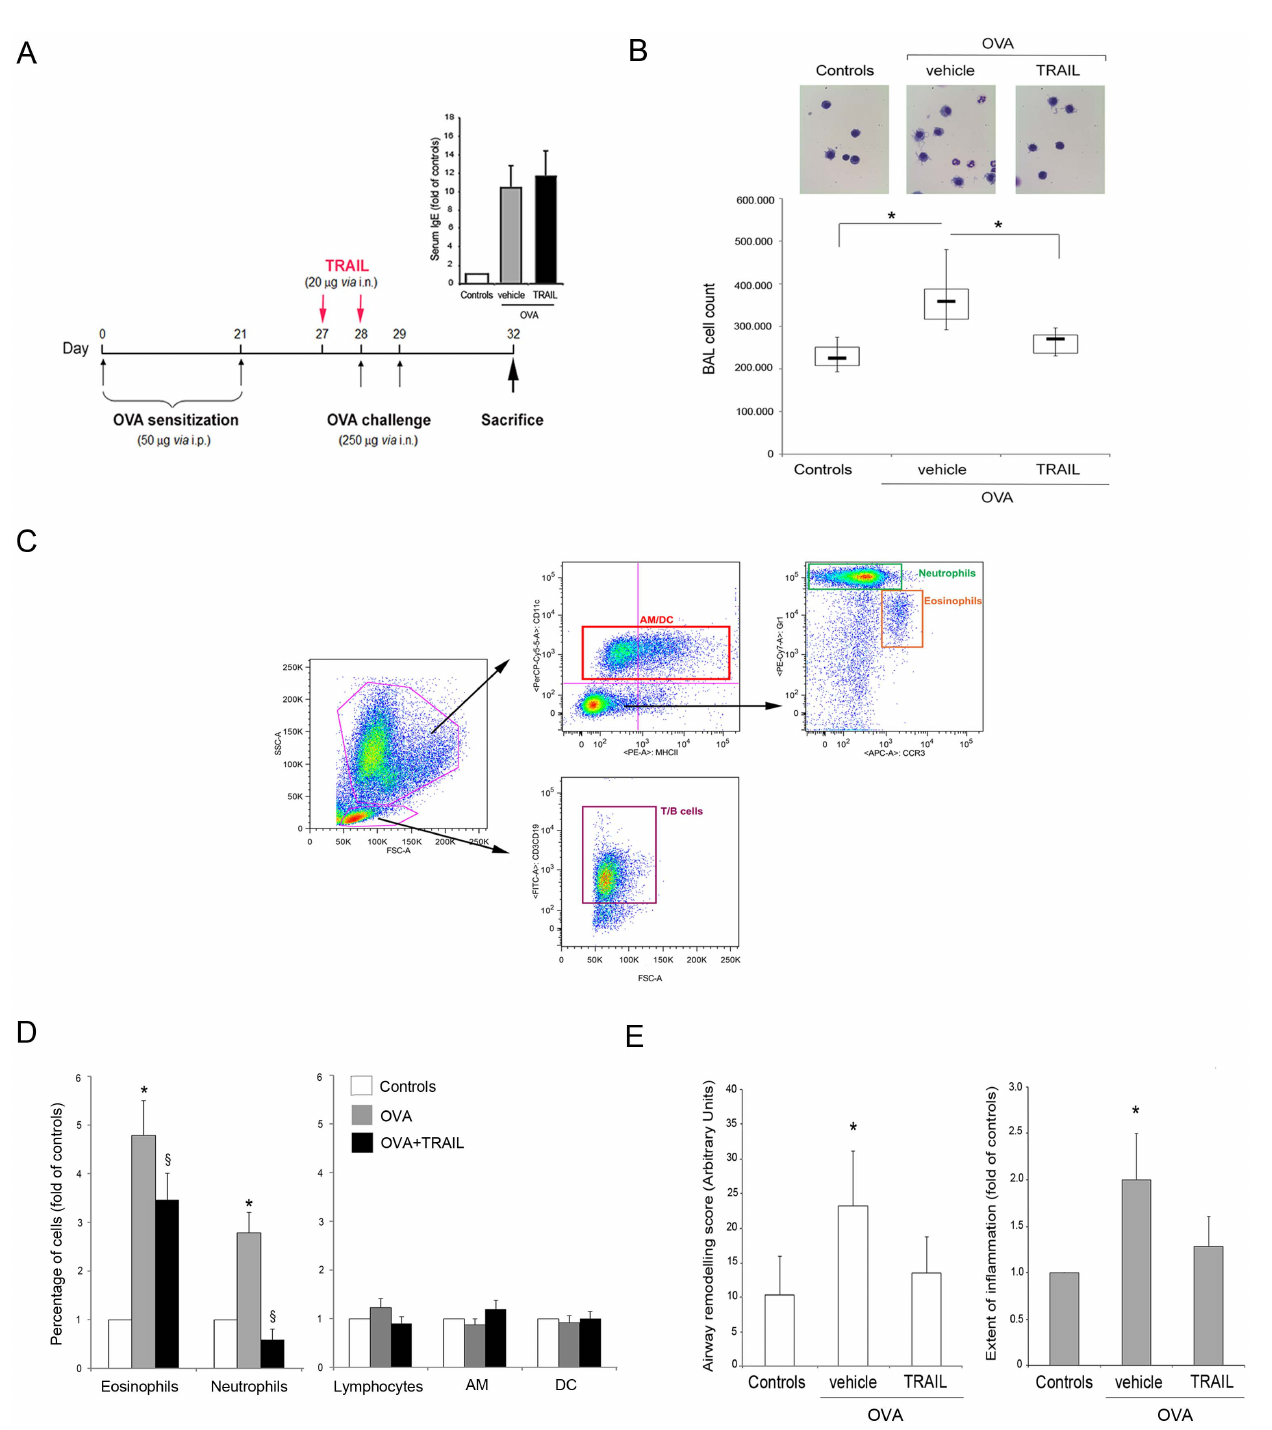
Fig. 3. Effect of recombinant TRAIL on OVA-induced airway inflammation. Mice were treated with recombinant TRAIL before OVA challenges and the cellular influx in the BAL was characterized. In A , the schedule and the timeline of recombinant TRAIL treatments with regard to OVA sensitizations/ challenges of BALB/c mice are shown. At the time of sacrifice (day 32), the circulating levels of total IgE were determined in serum samples of controls, OVA- and TRAIL + OVA-mice and expressed as fold of modulation with respect to controls ( insert ). In B , total cell count of cells present in BAL fluids of controls, OVA- and TRAIL + OVA-mice (n 5 16 mice/group) is shown. Horizontal bars are median, upper and lower edges of box are 75th and 25th percentiles, lines extending from box are 10th and 90th percentiles; *, P , 0.01. Representative images of May-Gru¨nwald Giemsa stained cytospins of BAL cells from each